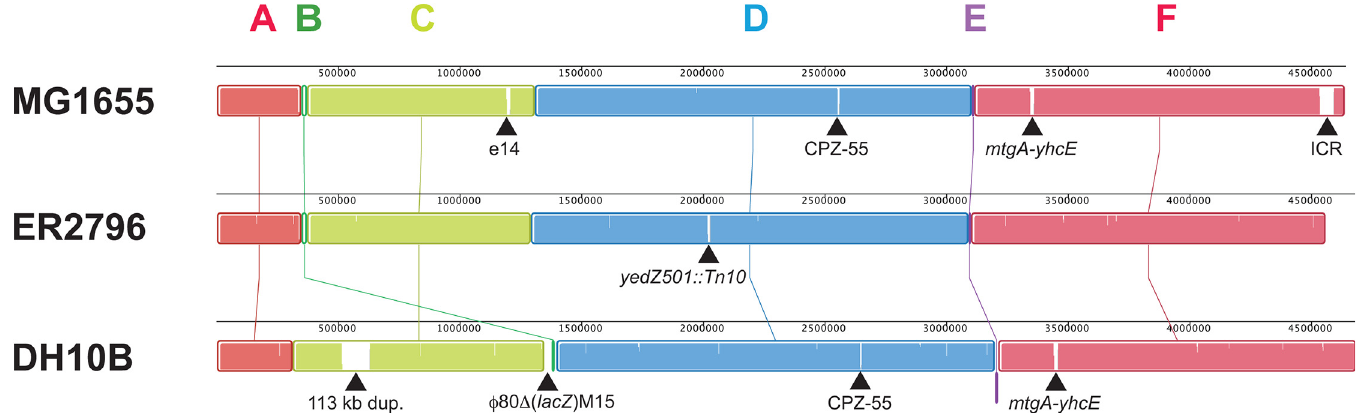
Fig 3. Alignment of the MG1655 genome with ER2796 and DH10B, conducted with Progressive-Mauve. Boundaries of the major contiguous blocks of sequence, labeled with capital letters, are formed by two major events specific to the DH10B lineage: block B results from deletion of a 34.6 kb region of MG1655 followed by partial restoration as part of a φ 80 Δ (lacZ)M15 mosaic prophage insertion in DH10B; and block E results from the IS10-mediated inversion of an 11 kb segment of MG1655, again in DH10B [4]. The following larger indels visible in the figure are labeled: prophage e14 lost in both ER2796 and DH10B; prophage CPZ-55 lost in ER2796; the 16 kb mtgA-yhcE region lost in ER2796 through IS5-mediated deletion; the ICR region deleted in both ER2796 and DH10B; Tn10 insertion at yedZ in ER2796; tandem duplication of a 113 kb region in DH10B, presumably IS5-mediated; the φ 80 Δ (lacZ)M15 mosaic prophage insertion in DH10B, including the lacZ region (part of block